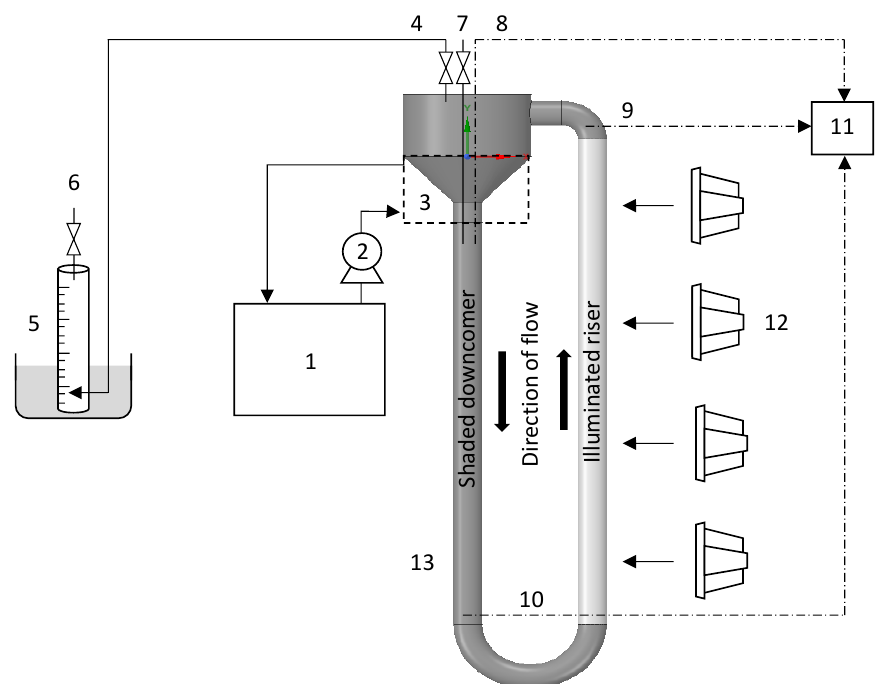
Figure 1. Schematic representation of the thermosiphon photobioreactor used for hydrogen production: (1) Water chiller; (2) Cooling water pump; (3) Cooling water jacket; (4) Gas collection port; (5) Inverted measuring cylinder submerged in water bath; (6) Gas sampling port; (7) Liquid sampling port; (8) Temperature probe 1; (9) Temperature probe 2; (10) Temperature probe 3; (11) Data logging unit; (12) Light source; (13) Photobioreactor.